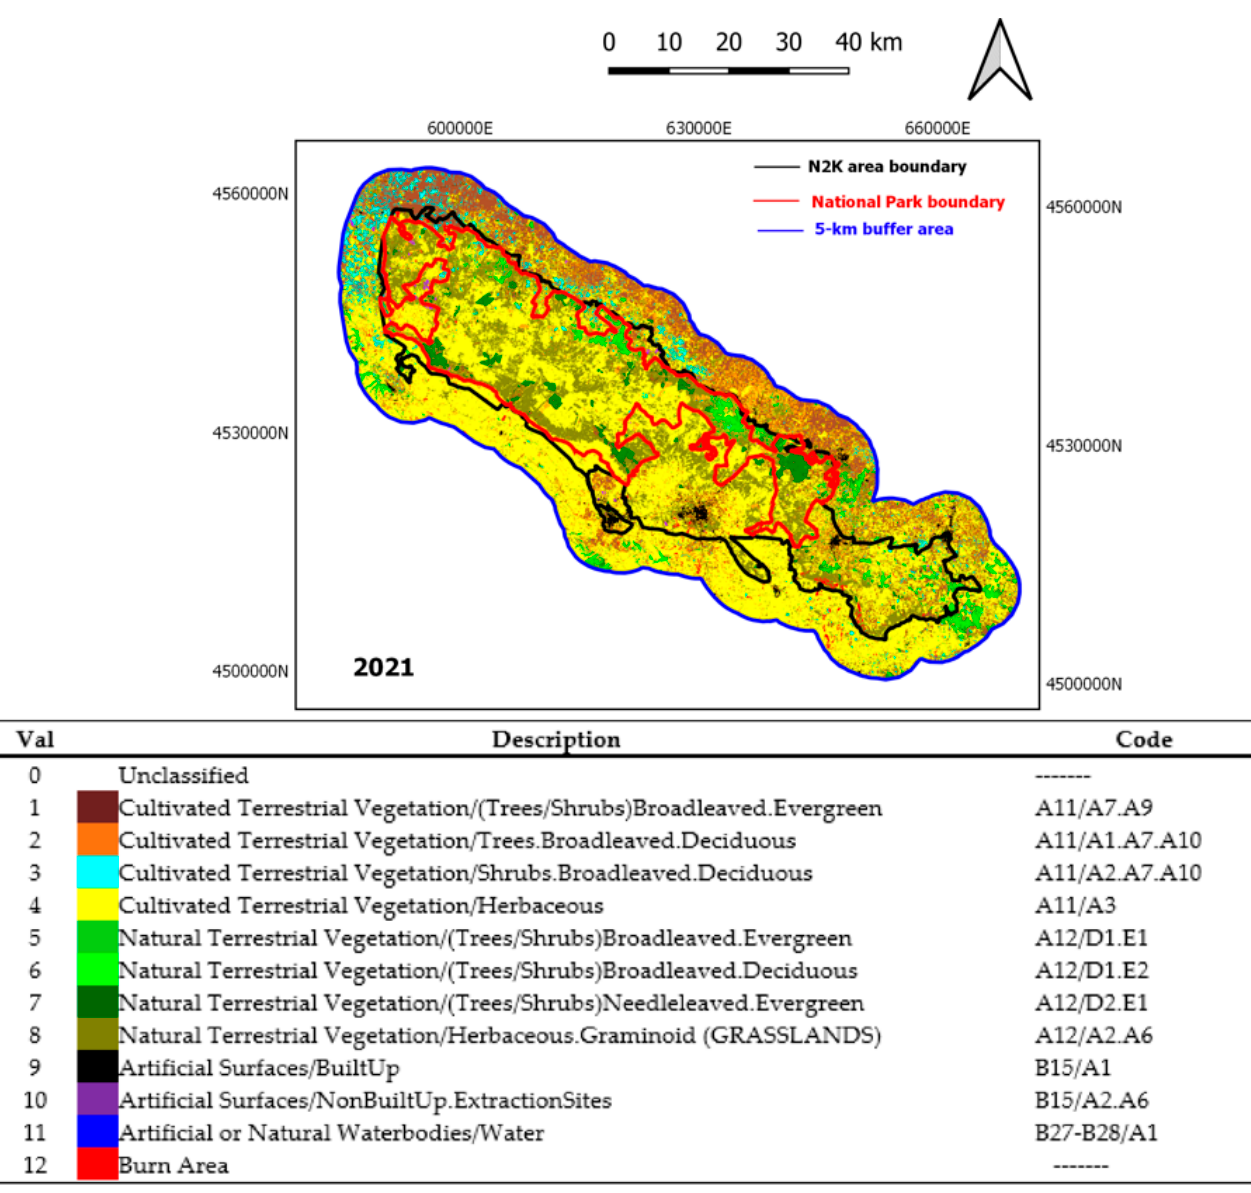
Figure 5. Trend of the NDVI mean values for grasslands across the four selected images for each year.